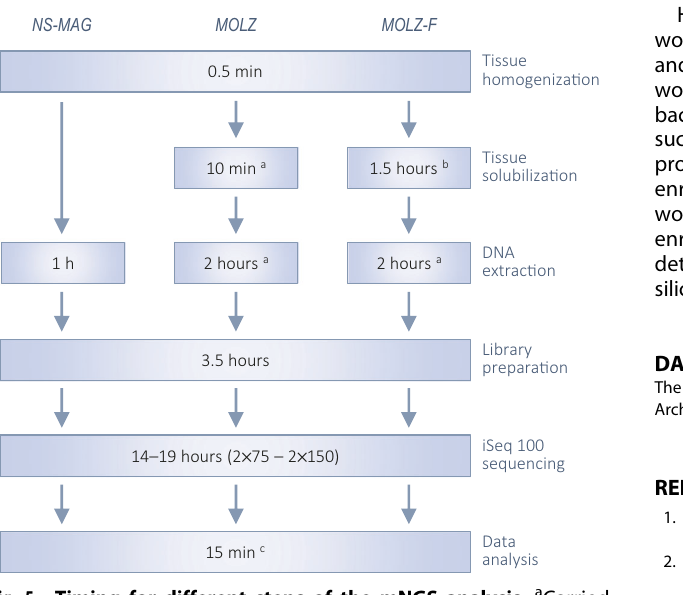
Fig. 5 Timing for different steps of the mNGS analysis. a Carried out with the Ultra-Deep Microbiome Prep (Molzym) kit and protocol for tissues. b Replacement of the proteinase K digestion by Liberase treatment and cell straining. c The estimate for an alpha version of our automated Kraken 2-based analysis for bacterial quanti fi cation of spiked-in samples. An additional 1.5-h incubation (without Liberase), introduced in this study in the NS-MAG and MOLZ procedures to adjust for the potential effect of bacterial DNA synthesis (that might occur in MOLZ-F during the 1.5-h tissue solubilization step), is not the control for reagent and other laboratory contaminants less important than when analyzing specimens with low microbial biomass [5]. In real clinical tests, the addition of the same amount of the calibrator bacteria in the clinical specimen and in corresponding blank sample would allow better distinction between contaminants and truly present microorganisms by the subsequent mNGS-based quanti fi cation. This also applies to situations with an incidental cross-contamination of the control sample by small amount of the clinical specimen; in this case, the absolute abundances are clearly more informative than the relative ones.